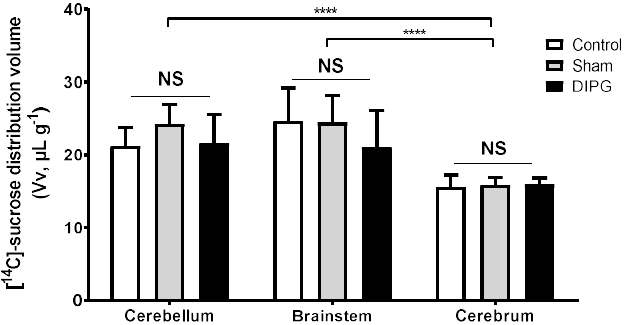
Figure 2. ( A–G ) E ff ect of the presence of DIPG (patient-derived HSJD-DIPG-007 tumor cells) on the integrity of the BBB to the passage of 3-kDa Texas Red-labeled Dextran (TRD, magenta) in control ( A , cerebellum; C , brainstem; E , cortex) and DIPG xenografts ( B , cerebellum; D , brainstem; F , cortex), and with [ 14 C]-sucrose ( G , cerebellum, brainstem, and cerebrum). ( A–F ) Sagittal brain sections were